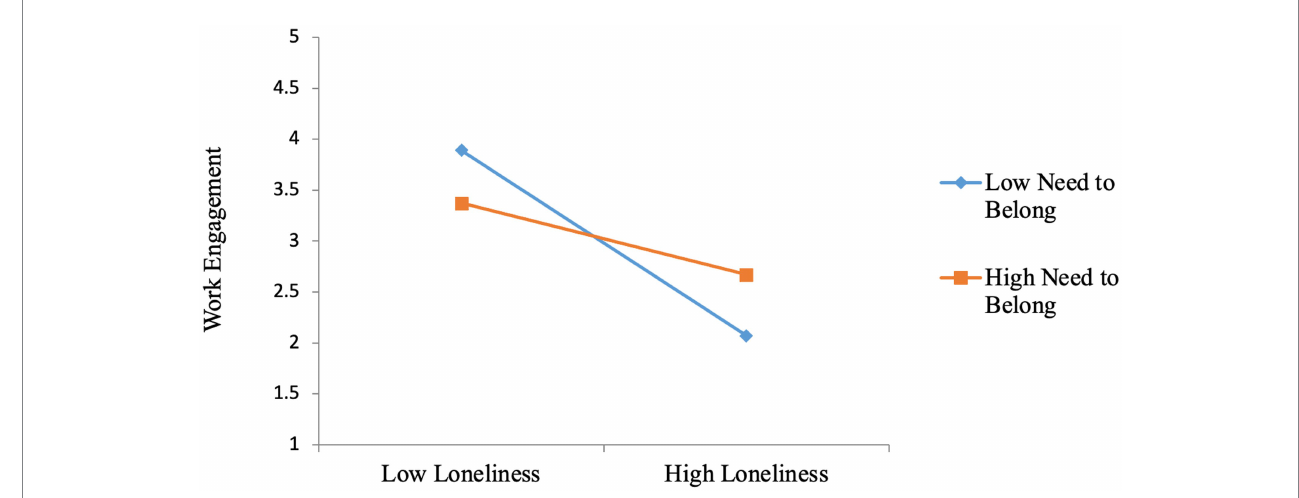
FIGURE 2 Combined effects of workplace lonelines and need to belong on work engagement.